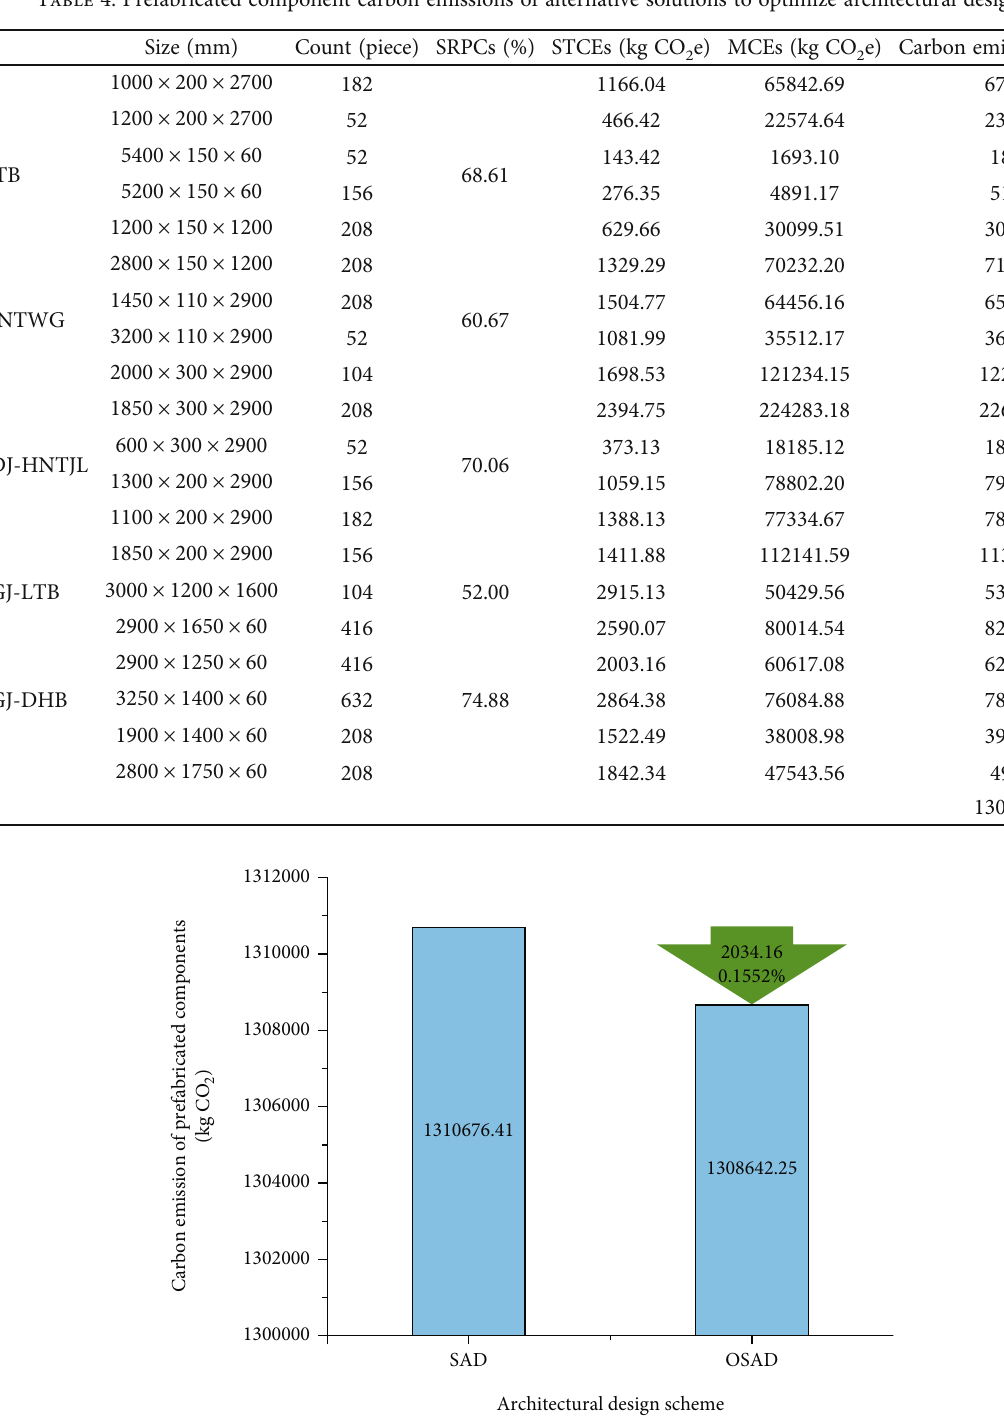
Figure 3: Comparison of carbon emissions for prefabricated components.